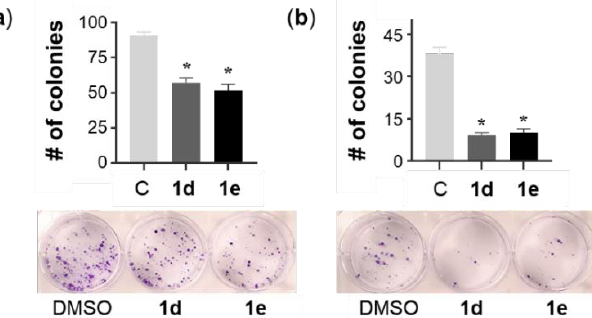
Figure 4. To study the drug withdrawal effect on A549 and NCI-H522 cell proliferation, ( a ) A549 cells (2000 cells/well) were treated with 0.72 µM of 1d and 0.64 µM of 1e , while ( b ) NCI-H522 cells (5000 cells/well) were treated with 0.56 µM of 1d and 0.46 µM of 1e , both for 72 h. Vehicle control cells were treated with DMSO (0.5%). Compound-containing medium was replaced with fresh medium, and the cells were allowed to grow for another 72 h. At the end of the treatment period, the cell number was determined by the SRB assay. The points represent the mean ± SEM ( n = 3). Data were analyzed using a two-way ANOVA coupled with a Bonferroni post hoc test. * Indicates a significant difference between the data points, p < 0.01.